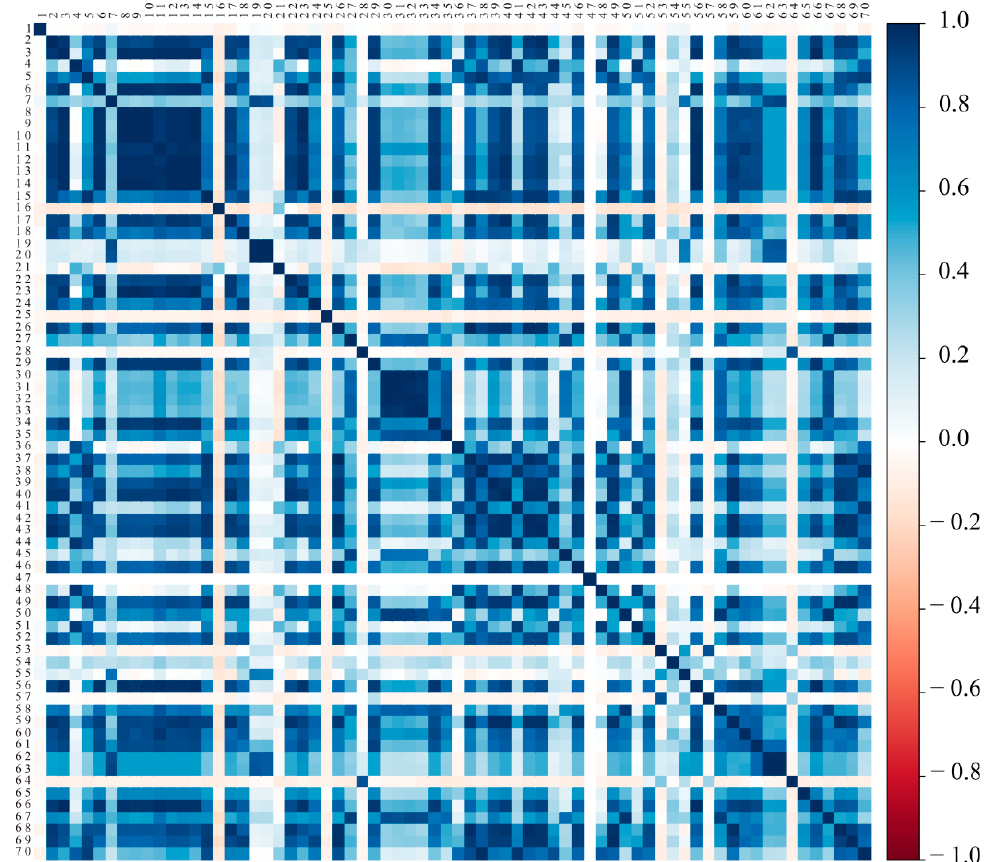
Figure 3. Correlation between different Hyssopus officinalis samples.